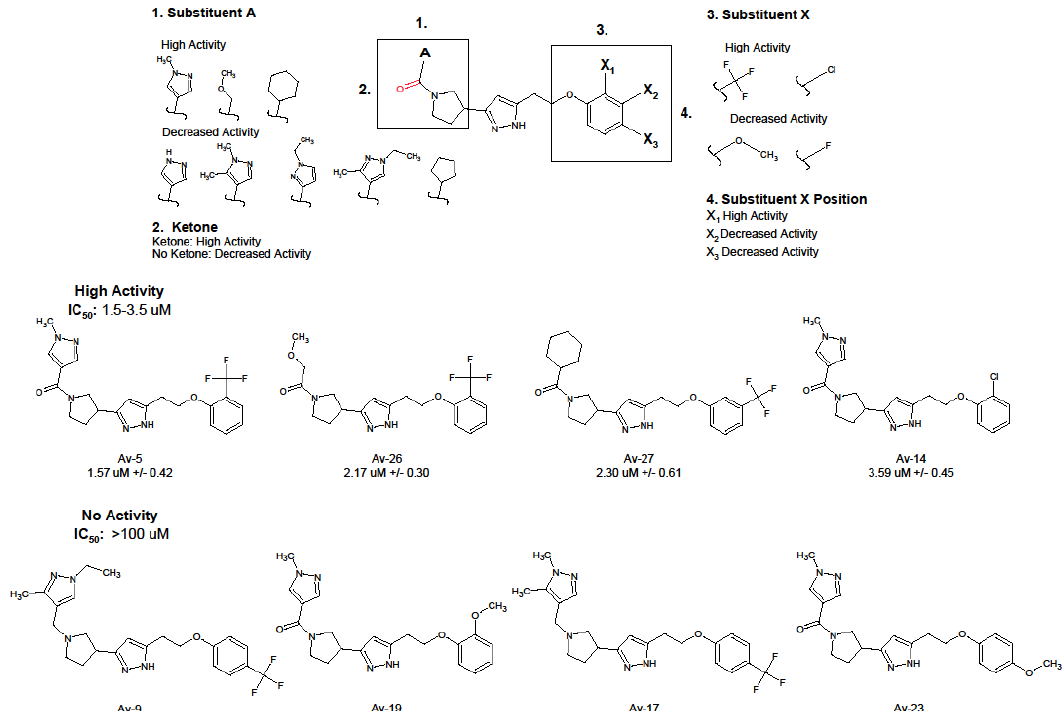
Figure 1. Structural and antiviral properties of Avirulins. Thirty compounds with structural similarity to the initial active compound were selected using a chemical database search program, SciFinder, and purchased from Asinex Corporation. Human immunodeficiency virus type 1 (HIV-1) antiviral inhibition of each compound was determined by a luciferase-based reporter assay measuring BaL infection of the HeLa derived cell line TZM-bl. TZM-bl contain the luciferase gene controlled by the HIV-1 Tat promoter and produce luminescence in response to infection. Inhibition was calculated by comparison of luminescence to the equivalent DMSO vehicle control. All 31 compounds were initially screened in triplicate at 50 µM for antiviral activity. Avirulins with detectable inhibition were further screened at lower concentrations for comparison of antiviral activity. Compounds with no inhibition at 50 µM were excluded from further evaluation. Trends in structural modifications to the Avirulin scaffold and the resulting change in antiviral activity and structures of four highly active Avirulins chosen as lead compounds for further analysis, and a selection of Avirulins with no antiviral activity are reported for structural comparison.